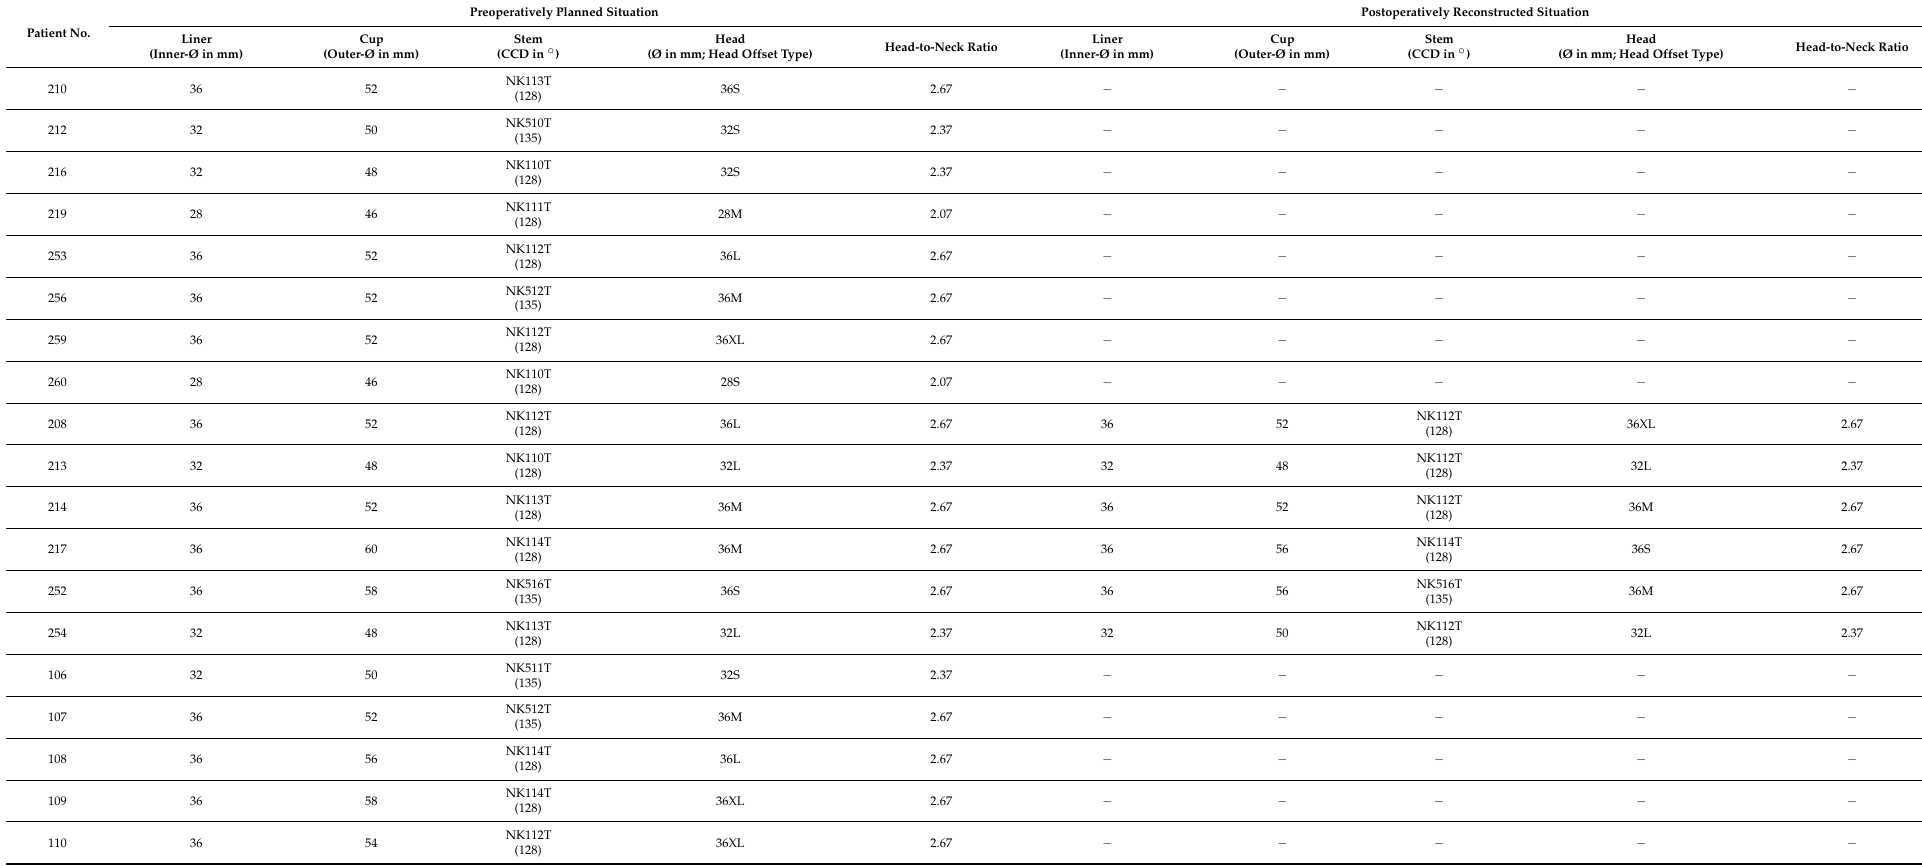
Table 1. Implant-specific parameters (cup size, head size, centrum–collum–diaphyseal (CCD) angles) virtually implanted for each patient case for the preoperatively planned situation and postoperatively reconstructed